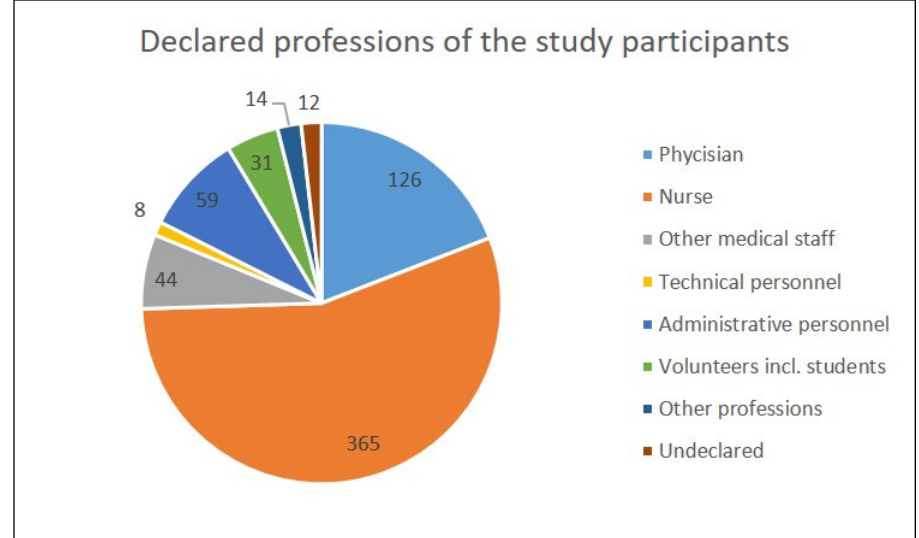
Figure 1. Number of study participants divided into groups based on their declared